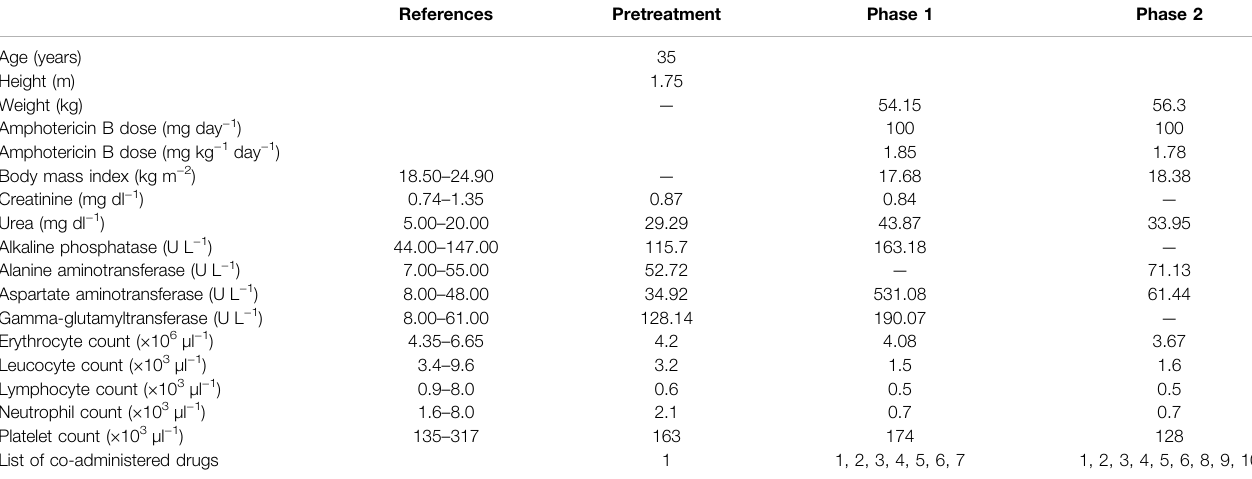
TABLE 1| Anthropometric, biochemical, and hematologicalparameters ofamale patienttreated for neurocryptococcosis with adosing regimen of100 mg ofamphotericin B lipid complex.